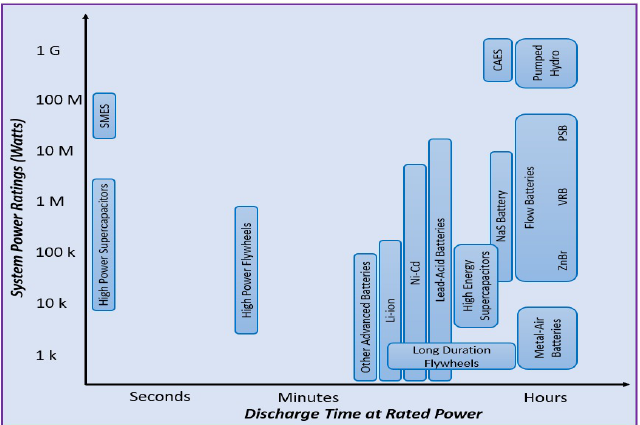
Figure 1. Characteristics of different ESS